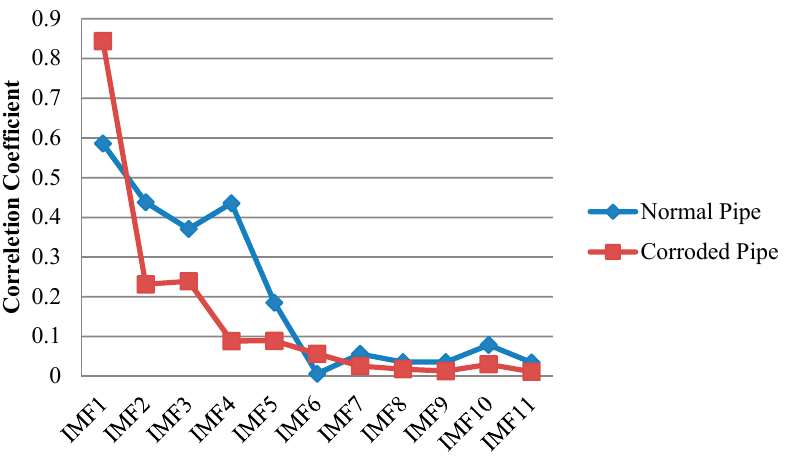
Figure 18. Absolute cross correlation of guided wave signals from the pipes in residential building with their corresponding IMFs obtained from EMD.